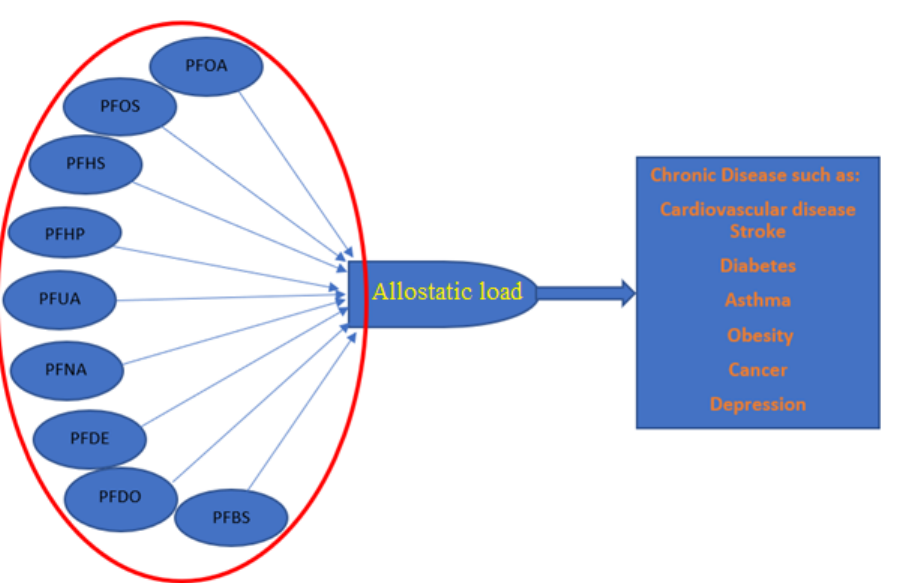
Figure 1. The potential relationship between PFASs and AL and the role AL may play as a mediator of chronic diseases outcomes.